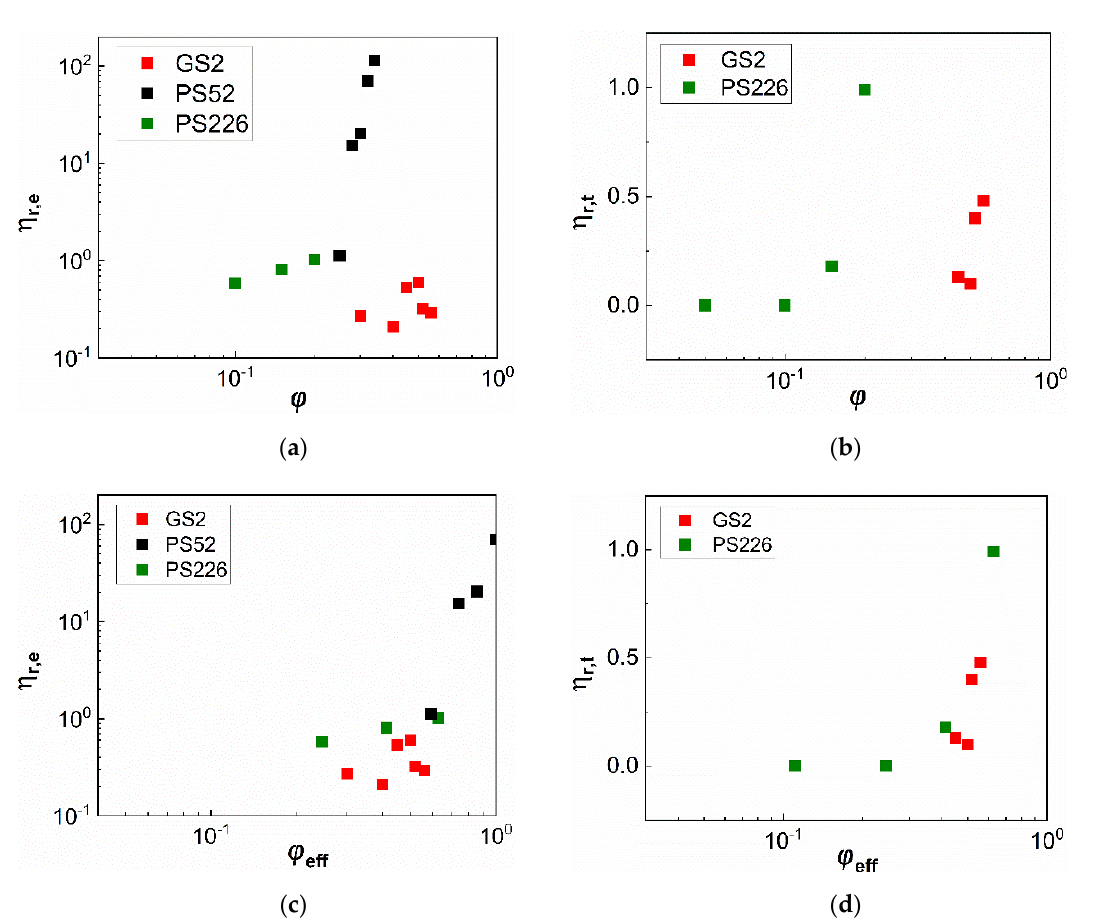
Figure 6. Extent of ( a ) shear thinning ( η r , e ) and ( b ) shear thickening ( η r , t ) of the suspensions exhibiting non-Newtonian rheology as a function of particle volume fractions ( ϕ ); ( c , d ) represent the same data with ( a , b ) as a function of the e ff ective particle volume fraction ( ϕ ef f ). In the case of PS226, the ϕ ef f values were estimated using the experimentally derived density.